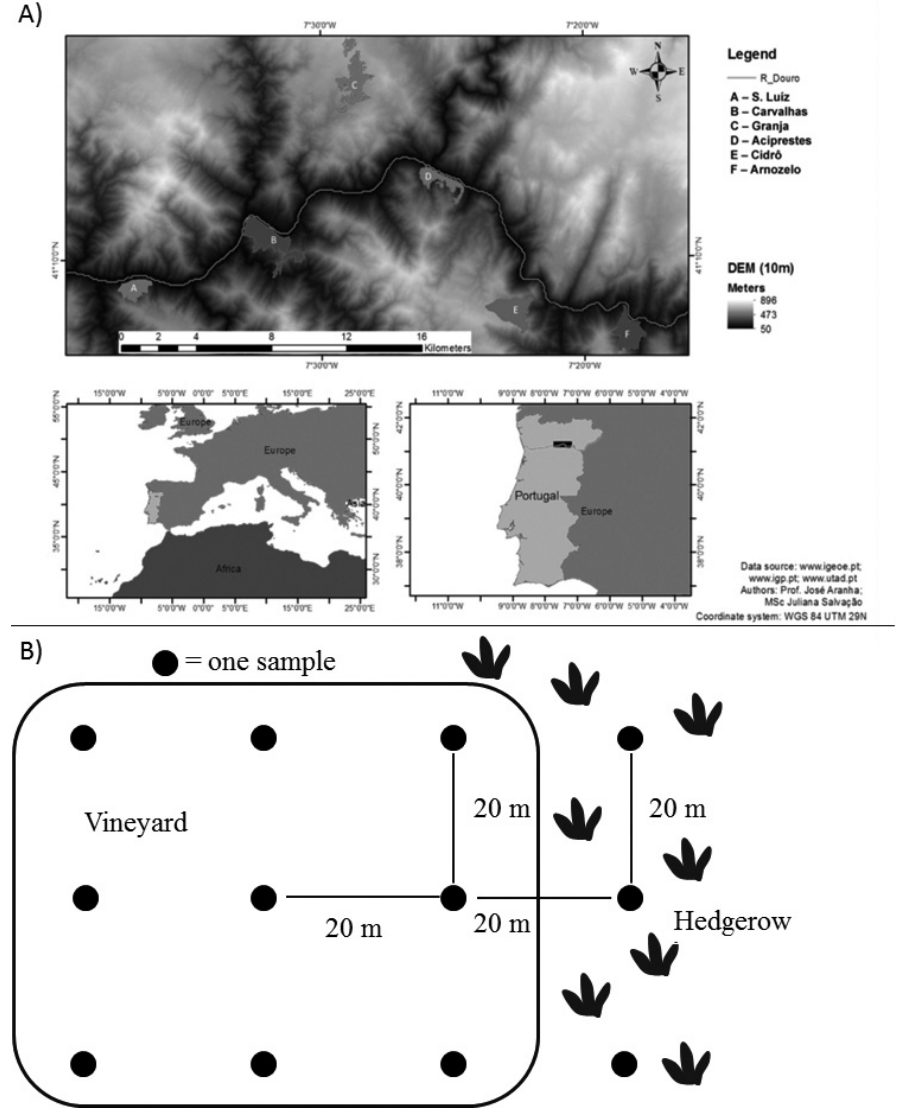
Figure 1. Geographic coordinates and altitudes of the farms and details of the soil sampling strategy adopted. a Details of the six farms of the Douro Wine Region, Portugal, which were considered in this study b Details of the soil sampling strategy from vineyards and adjacent